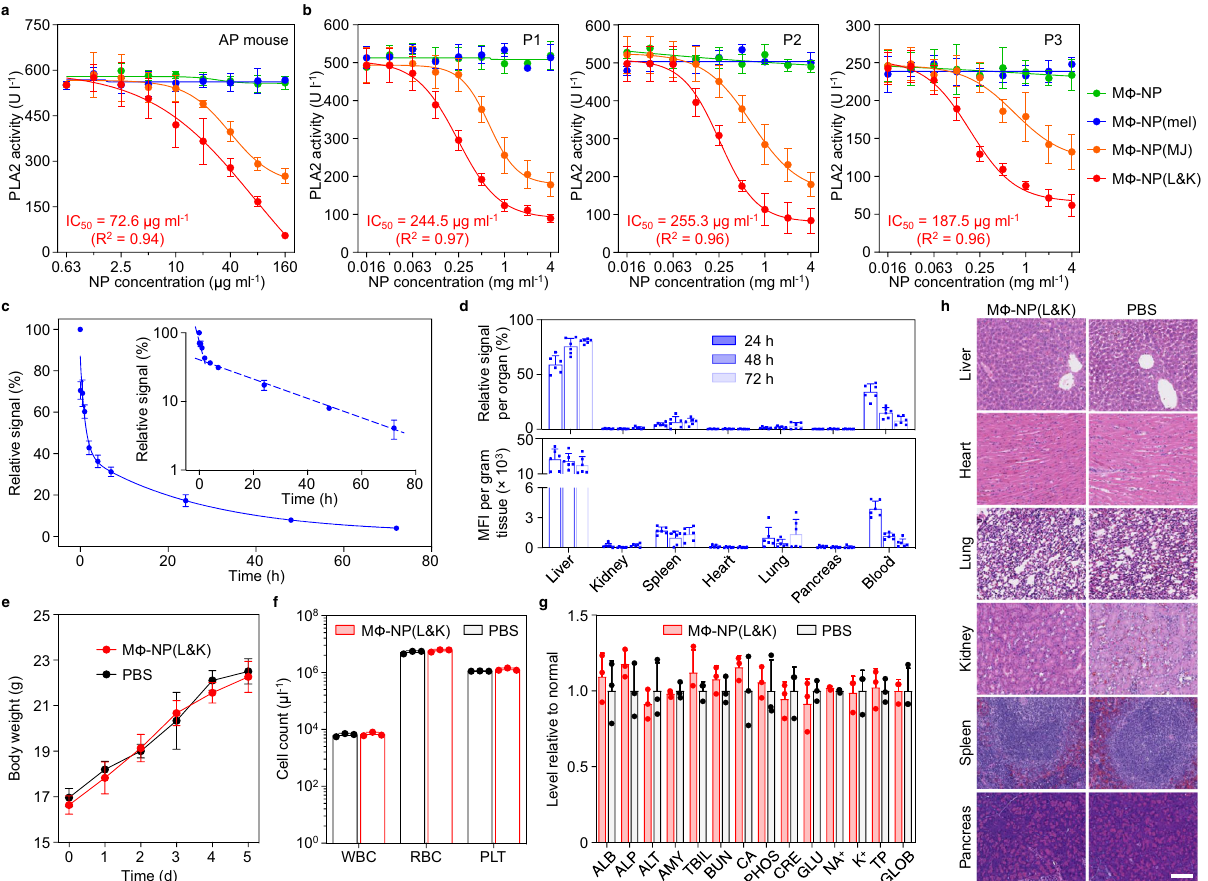
Fig. 2 PLA2 inhibition capacity and in vivo characterizations. Comparison of the inhibition capacity of M Ф -NP, M Φ -NP(mel), M Φ -NP(MJ), and M Φ -NP (L&K) against PLA2 in serum from mice with acute pancreatitis ( a ) and human patients with acute pancreatitis ( b ). c Pharmacokinetics of M Φ -NP(L&K). DiR-loaded nanoparticles were injected intravenously through the tail vein of mice. At various timepoints, blood was withdrawn intraorbitally and measured for fl uorescence at 780 nm to evaluate the systemic circulation lifetime of the nanoparticles (inset, semi-log plot of fl uorescence at various timepoints). d Biodistribution of M Φ -NP(L&K). Fluorescently labeled nanoparticles were injected intravenously into the mice. At each timepoint (24, 48, and 72 h), the organs from a randomly grouped subset of mice were collected, homogenized, and quanti fi ed for fl uorescence (top: relative signal per organ, bottom: fl uorescence intensity per gram of tissue). e – h Safety of M Φ -NP(L&K). Healthy mice received intravenous injections of PBS or M Φ -NP(L&K) (80 mg/kg) daily on days 1 – 4. e Body weights of mice taken from day 0 to day 5. f Blood cell counts measured on day 5. WBC white blood cells, RBC red blood cells, PLT platelets. g Comprehensive blood chemistry panel performed on day 5. ALB albumin, ALP alkaline phosphatase, ALT alanine transaminase, AMY amylase, TBIL total bilirubin, BUN blood urea nitrogen, CA calcium, PHOS phosphorus, CRE creatinine, GLU glucose, NA + sodium, K + potassium, TP total protein, GLOB globulin (calculated). h H&E-stained histological sections from major organs on day 5. Scale bar, 100 μ m. Data presented as mean ± s.d. In all